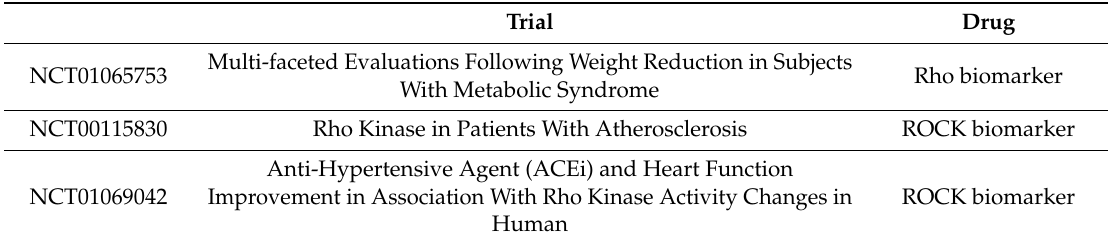
Rho biomarker ROCK